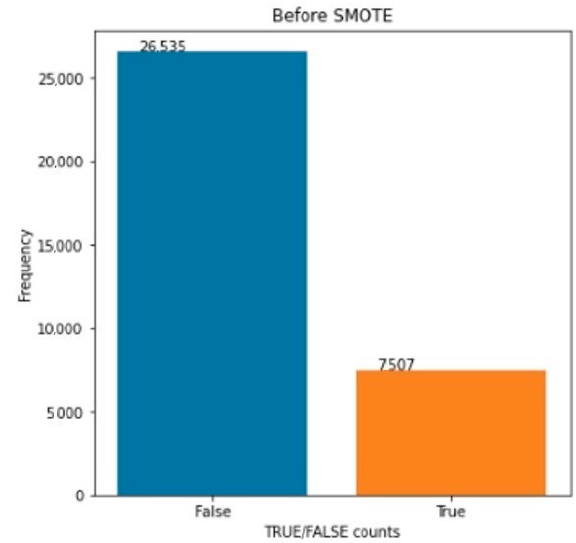
Figure 2. Dataset classes distribution.